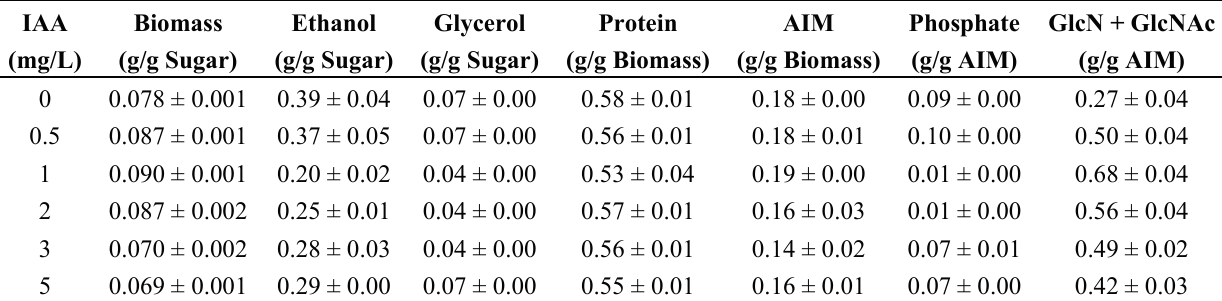
Table 1. The biomass, ethanol, glycerol, protein, AIM (Alkali Insoluble Material), phosphate, and sum of glucosamine (GlcN) and N -acetyl glucosamine (GlcNAc) in the presence of indole-3-acetic acid (IAA).